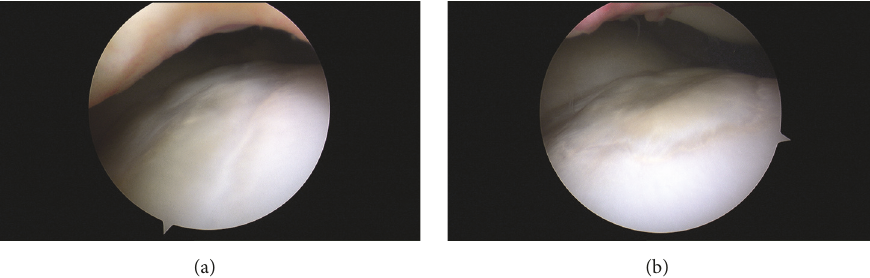
Figure 2: Two views of the second-look arthroscopy. ((a) and (b)) Intra-articular view of the femoral trochlea demonstrating the formed cartilage flush with the surrounding cartilage, adequate filling of the defect, and adequate transition between the healthy and formed